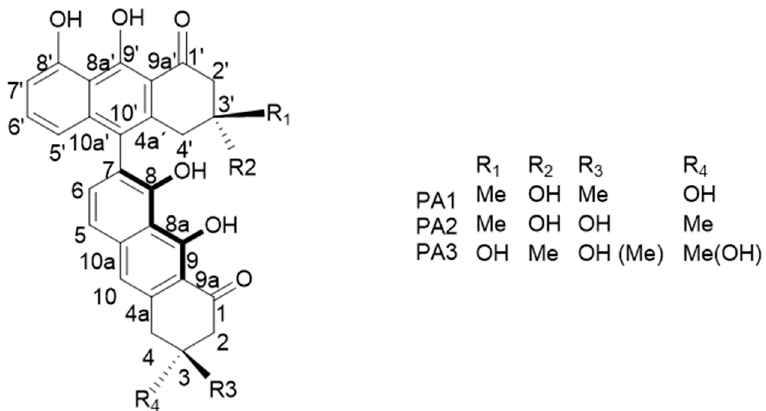
Figure 2. Isomers of T514 (peroxisomicine A1 or PA1).